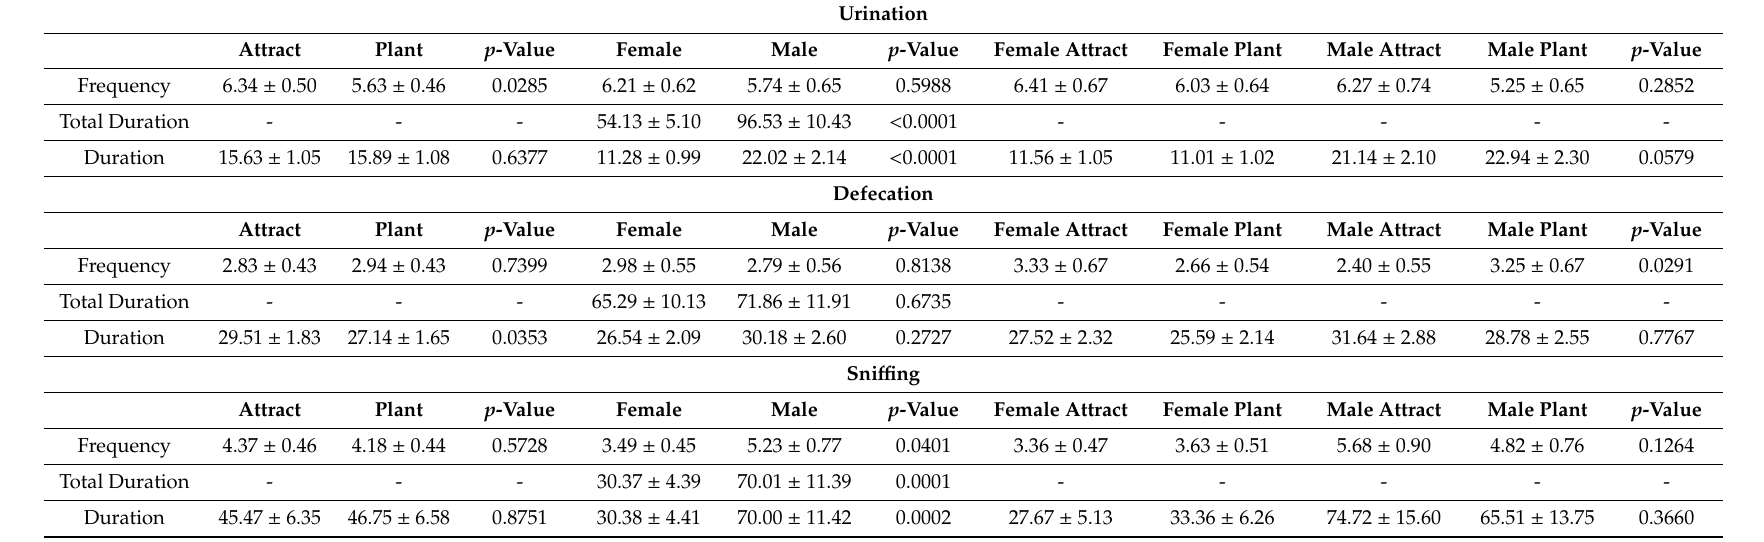
Table 4. Least square means ( ± SD) for count, total duration and duration of urination, defecation and sni ff